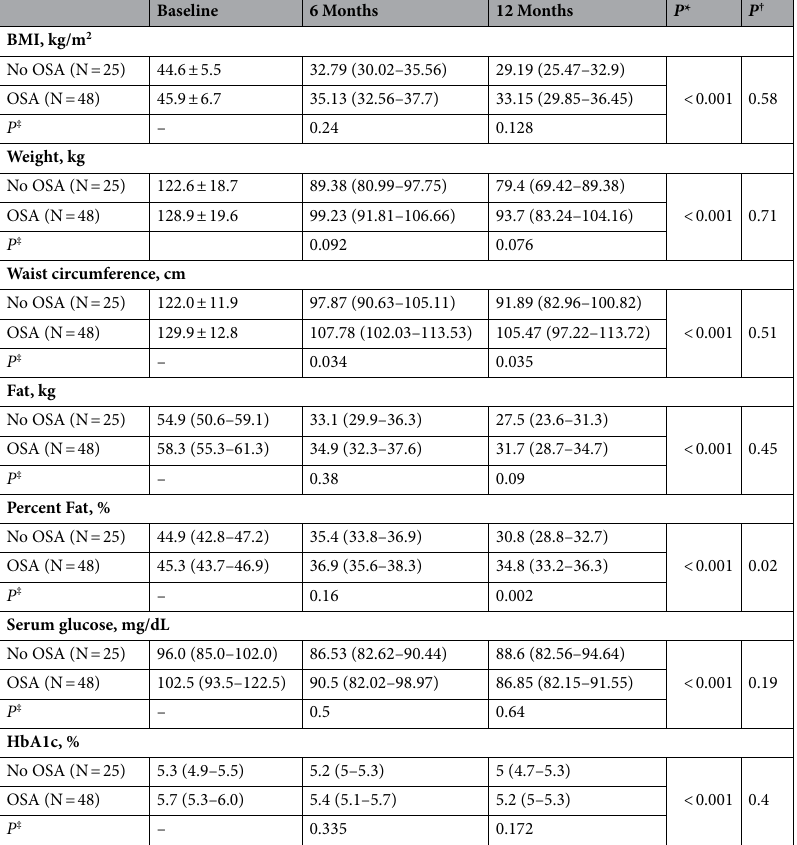
Table 2. BMI, weight, waist circumference, Fat and Percent Fat, serum glucose and HbA1c levels evolution during the follow-up across the two OSA groups. Data are presented as mean (95%CI) at baseline, and least-squares mean (95%CI) at 6 and 12 months. Analysis was conducted using a mixed model for repeated measures, adjusting for baseline values. Adjusting also for diabetes didn’t change the significance of the results. * P value for time effect – trend over time in all arms. † P value for treatment x time interaction – evaluates if changes in one group are different from the changes in the other group. ‡ P value for comparison between groups at each moment; BMI—body mass index; HbA1c—glycated